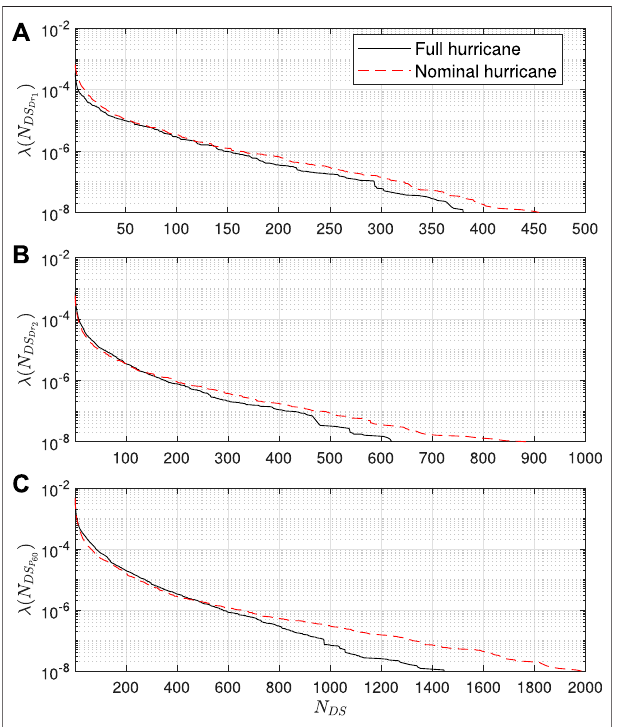
FIGURE 9 | Mean annual rate of exceeding a total number of envelope componentsassumingasa fi naldamagestate: (A) DS Dr